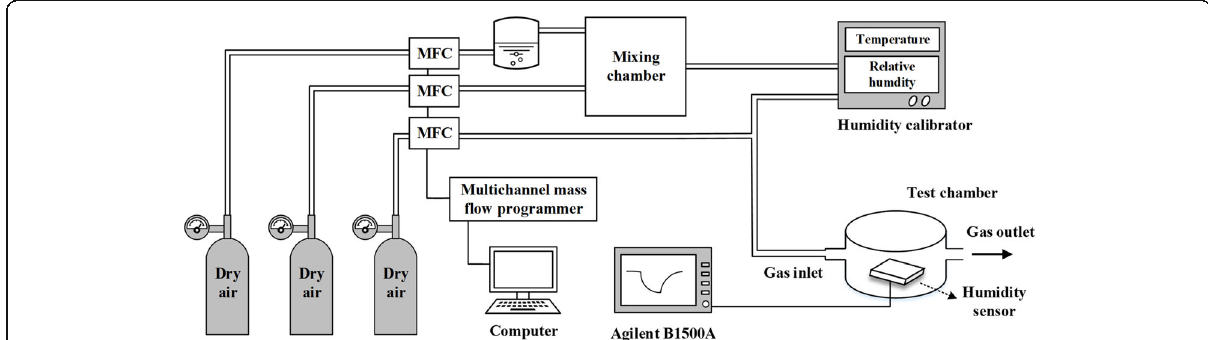
Fig. 2 Measurement setups. All characteristics of sensors were tested at 25 °C (room